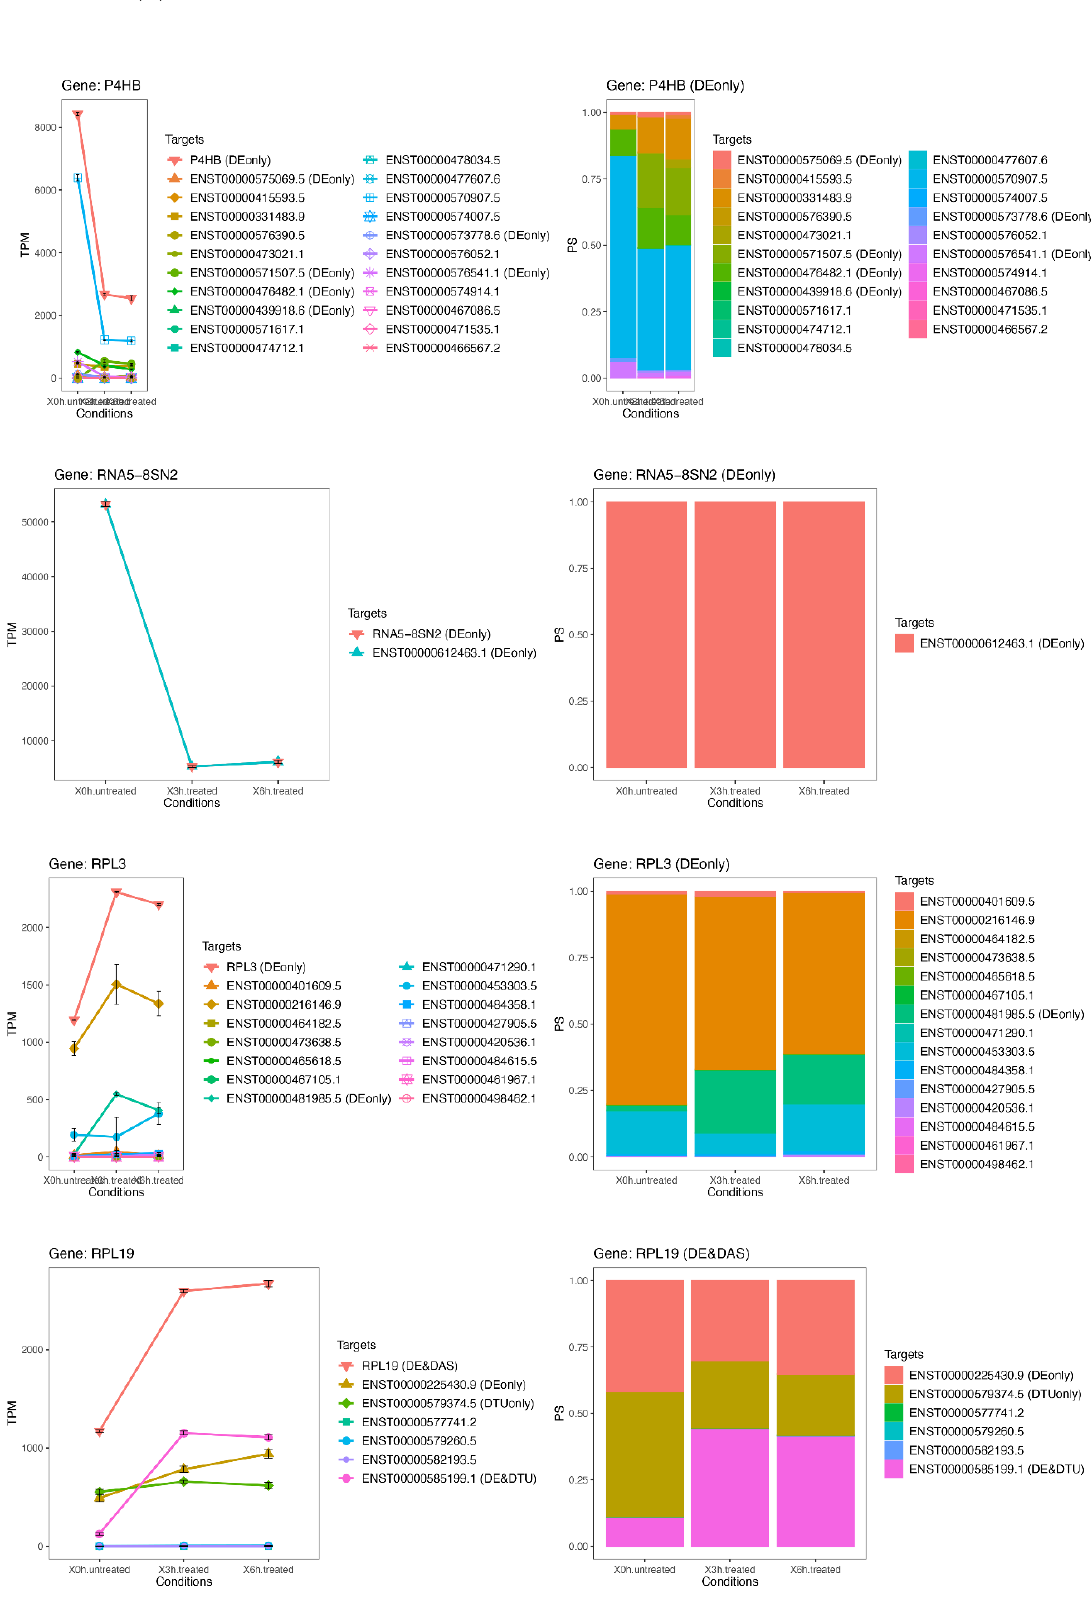
Figure 8. Expression profiles of most important DE genes / transcripts secondo cluster associated with newly discovered pathways linked to oxidative stress. Detailed gene / transcript expression profiles across the time course of the second cluster of most important DE genes ( P4HB , RNA5-8SN2, RPL3 and RPL19) linked to newly identified candidate pathways linked to oxidative